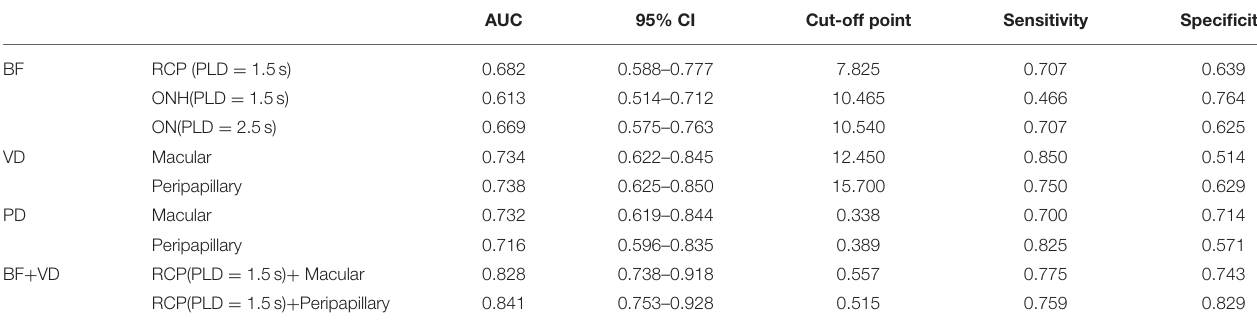
TABLE 5 | The AUC and cutoff values of BF, VD, and PD for the differential diagnosis of PDR. AUC 95% CI Cut-off point Sensitivity Specificity